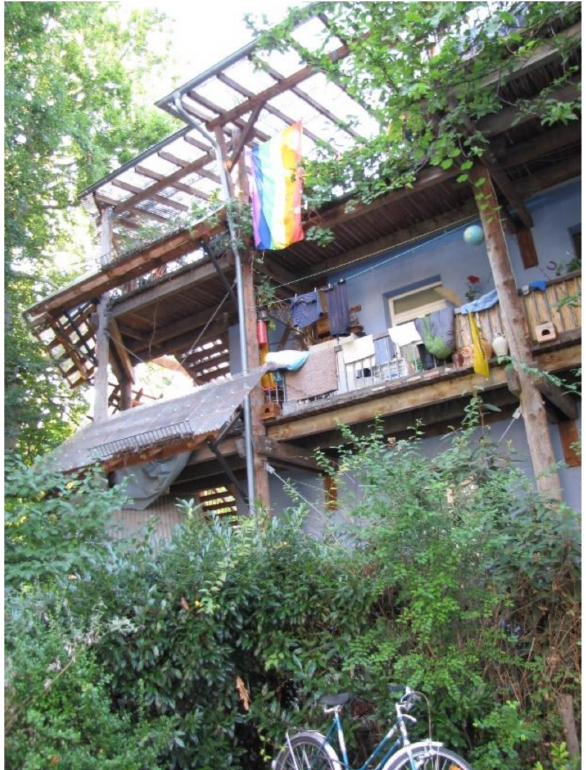
Figure 17. Vauban Kaserne housing district after regeneration (photo by M.